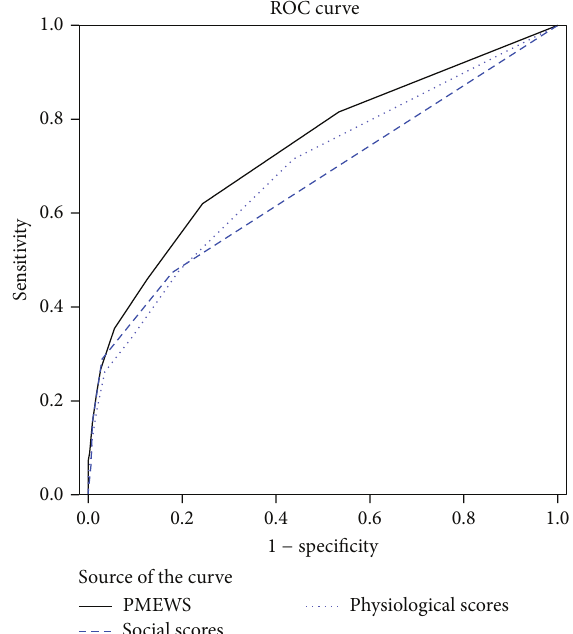
Figure 2: ROC curve for physiological, social, and PMEWS scores as predictors of need of the EMS